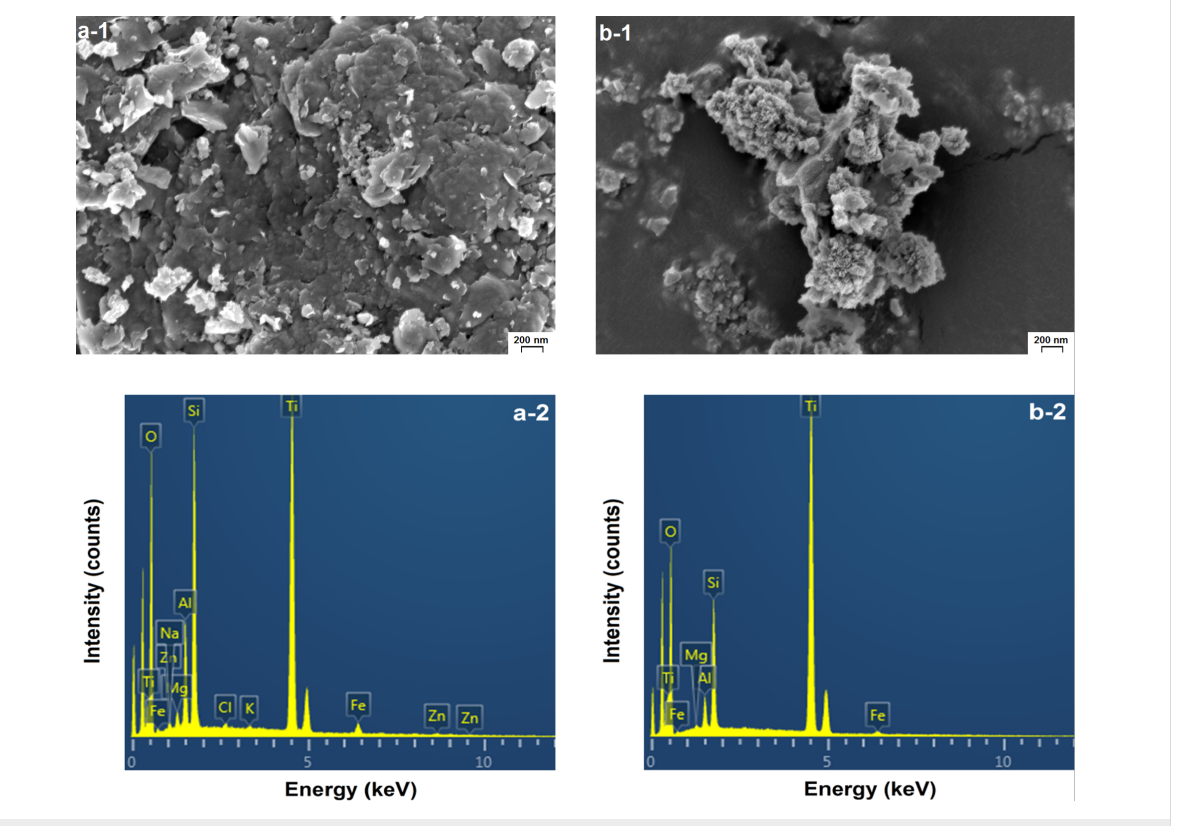
Figure 5: SEM images and EDS spectra of the surface of (a) TiO 2 -PMM500, and (b) TiO 2 -PMMH500.